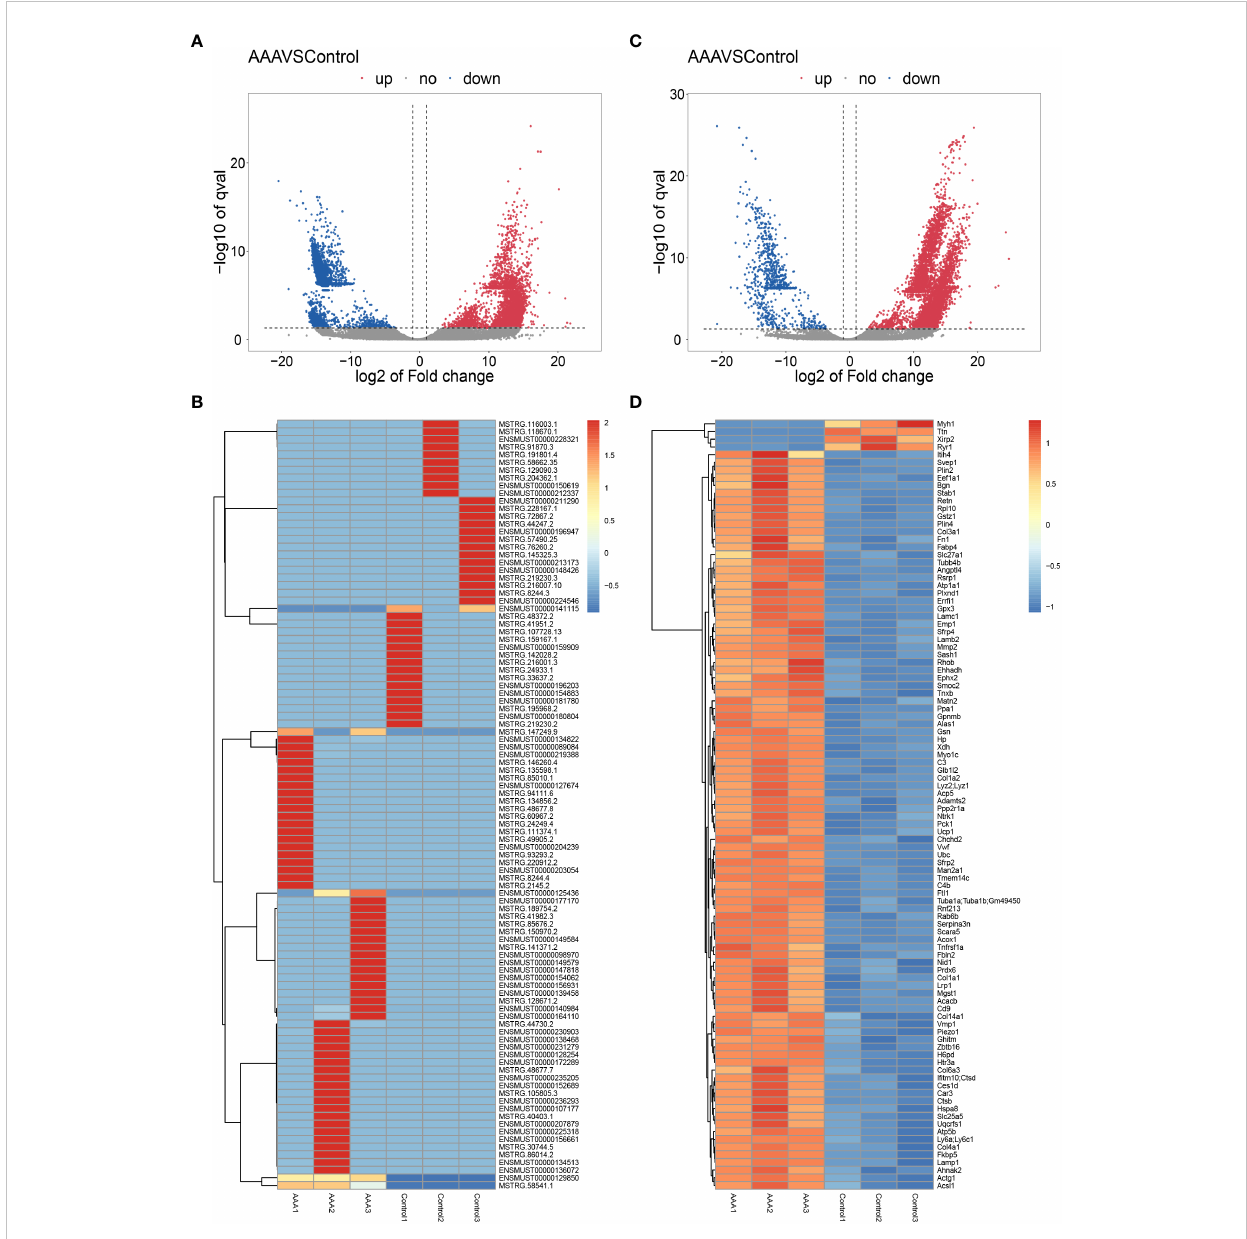
FIGURE 2 Expression pro fi les of LncRNAs and mRNAs in mouse after AAA. Scatter-plot for comparing global expression pro fi les of lncRNAs (A) and mRNAs (C) in the artery between the AAA and sham-operated mice. X and Y axes indicate the mean normalized signal values (log2 scaled). Blue points represent up-regulated lncRNAs or mRNAs while red points represent downregulated lncRNAs or mRNAs. The heat map shows hierarchical clustering of DElncRNAs (B) and DEmRNAs (D) in the artery between the AAA and sham-operated mice. The color scale indicates the expression of DElncRNAs and